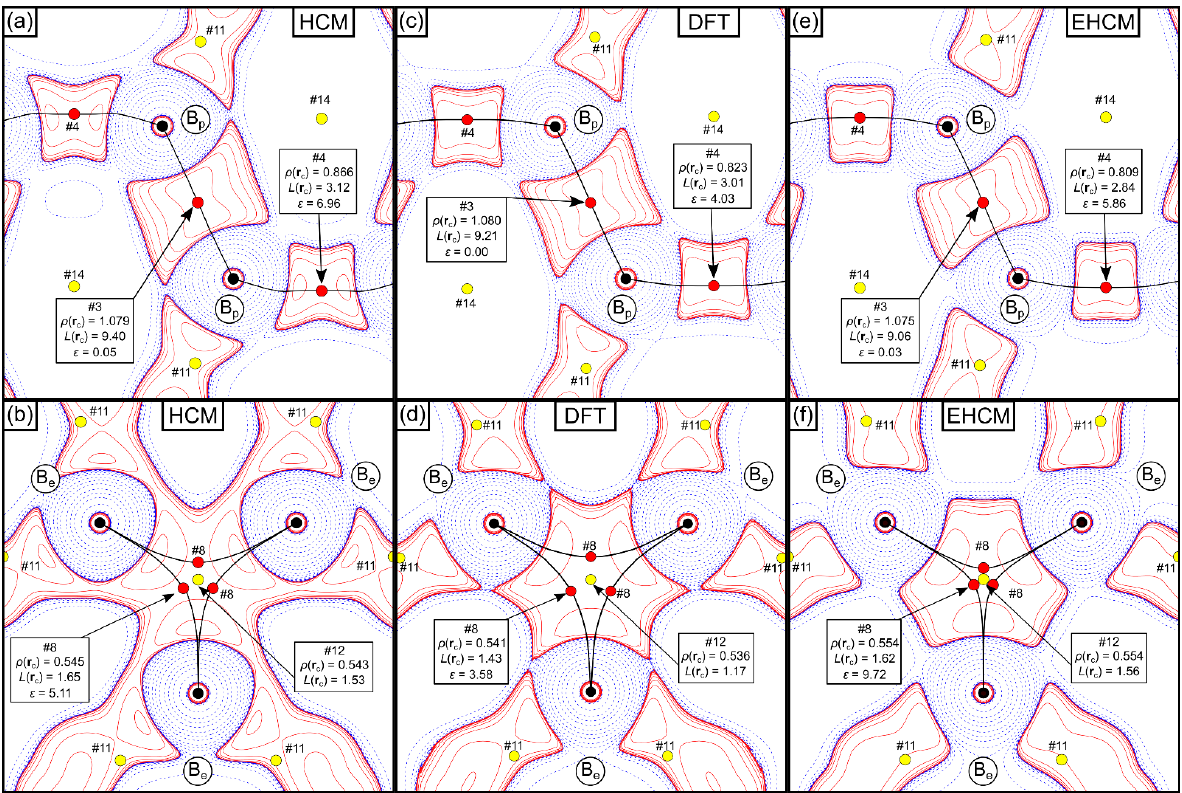
Figure 3. L ( r ) = − ∇ ² ρ ( r ) maps of the intericosahedral ( a , c , e ) (2c,2e)-B p -B p bond and ( b , d , f ) (3c,2e)-B e -B e -B e bond in α-boron from the experimental HCM refinement ( a , b ), DFT calculation ( c , d ) and experimental EHCM(asph) refinement ( e , f ). Positive (solid red) and negative (dashed blue) contour lines are shown at ±2·10 n , ±4·10 n , ±8·10 n eÅ −5 , n = ±3, ±2, ±1, 0. ρ ( r c )- and L ( r c )-values are given in eÅ −3 and eÅ −5 , respectively. The numbers (e.g., #4, #8, #12, etc.) next to the critical points correspond to the numbering scheme of the CPs in Table 1 and Table S1, Supporting Information.